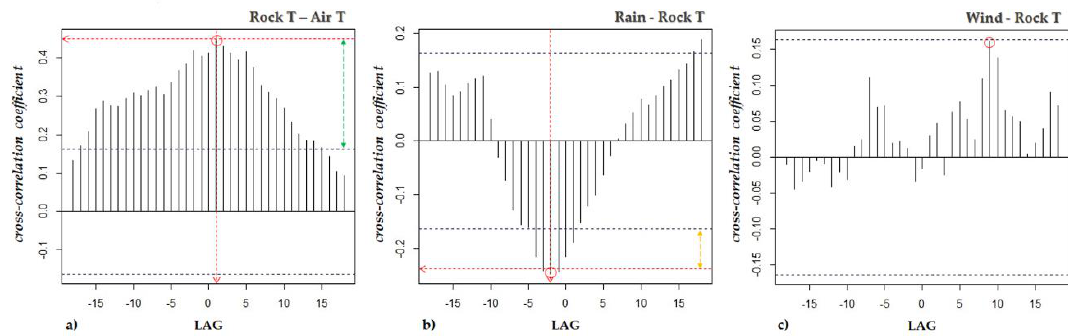
Figure 9. ( a ) Correlogram of the cross-correlation between the rock temperature and the air temperature. The air temperature always anticipates the rock temperature. The green arrow indicates the statistical significance of the result. ( b ) Correlogram of the cross-correlation between rainfall and the rock temperature. The rainfall anticipates the rock temperature, but with a very low CF value. The yellow arrow indicates the low statistical significance of the result. ( c ) Correlogram of the cross-correlation between the wind speed and the rock temperature. No peak of cross-correlation is evident on the graph, and the results remain below the statistical significance threshold. The LAG value is expressed as a multiple of the sampling step of R 2 (equal to 10 min, which represent the unit value of LAG).